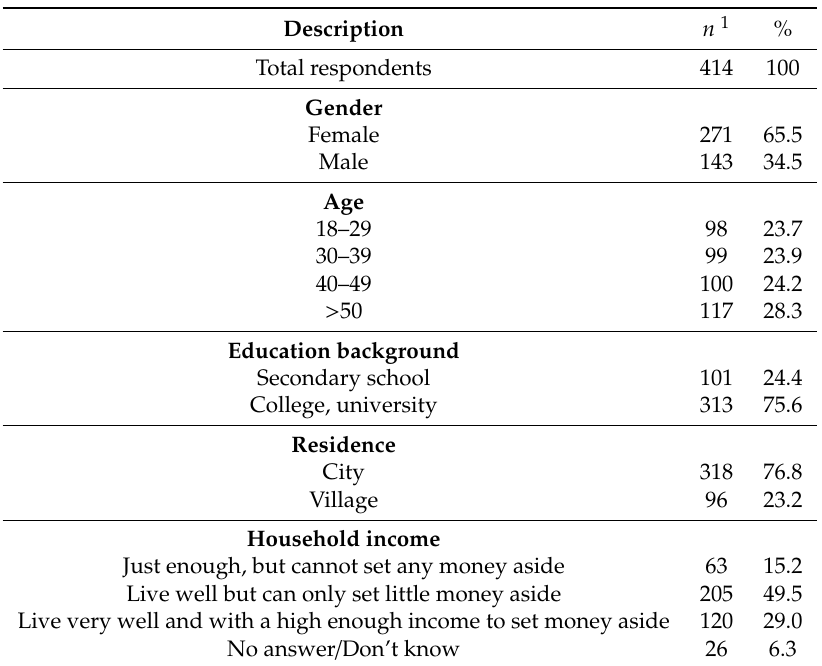
Table 1. Distribution of the sample.